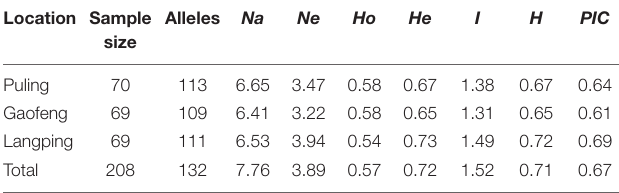
TABLE 1 | Genetic characterization of three wild A. biserrata